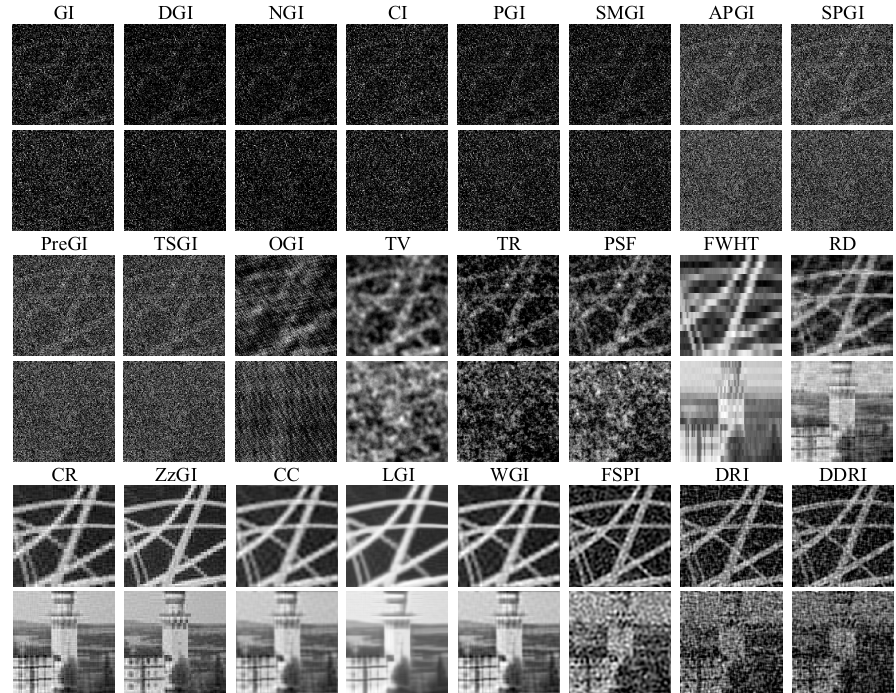
Figure 5. Simulation results of twenty-four methods with WGN. The noise level is 45. Table 5. PSNR and RMSE of images corresponding to Figure 5.